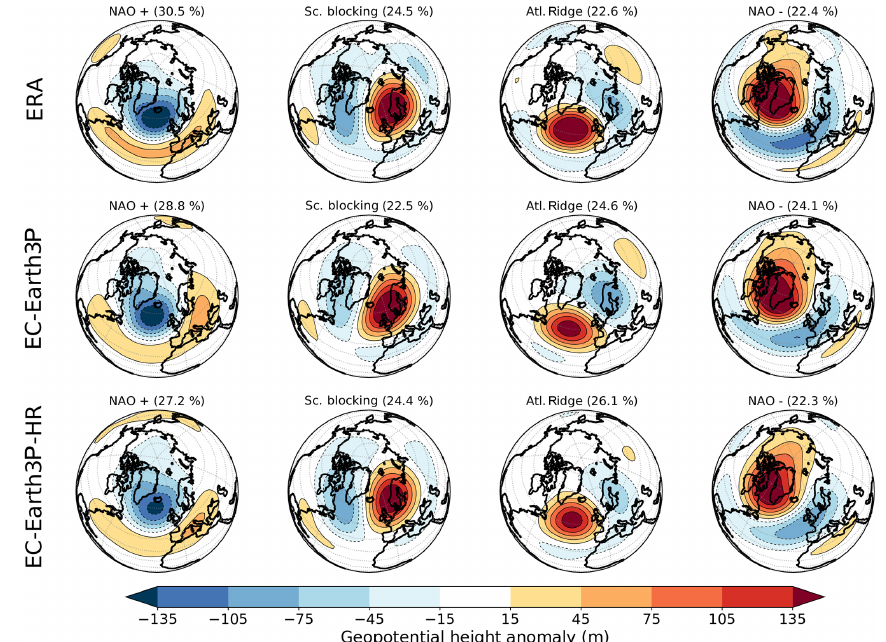
Figure 19. Observed cluster patterns for ERA (a) , simulated cluster patterns in hist-1950 for EC-Earth3P (b) and EC-Earth3P-HR (c) . The frequency of occurrence of each regime is shown above each subplot.